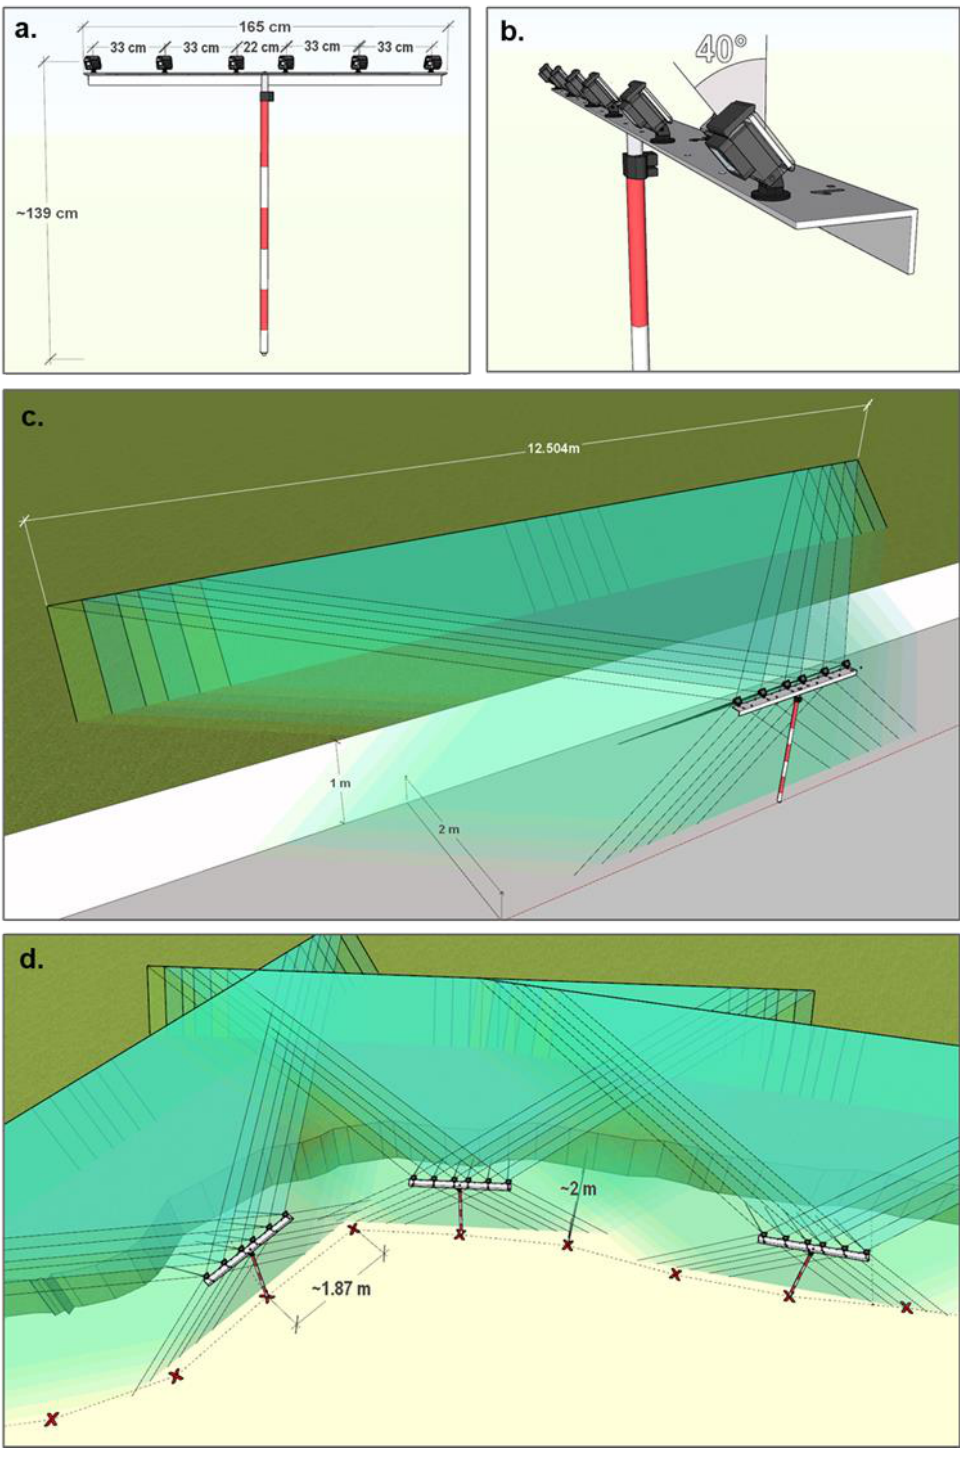
Figure 2. Camera grid representation in SketchUp 2018. ( a ) Camera grid dimensions showing height, width and spacing of cameras. ( b ) Camera declination from the z -axis. ( c ) Estimated camera FOVs for the camera rig. ( d ) Representation of camera rig movement in relation to the scene of reconstruction — the cross marks the location of the camera rig for image capture.